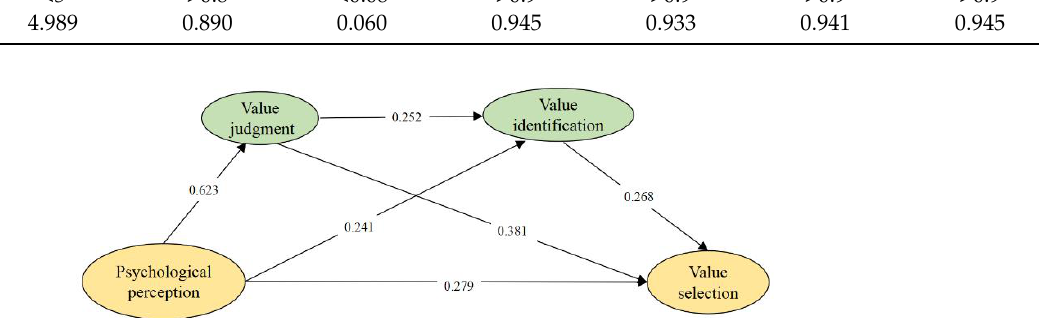
Figure 1. Theoretical model.